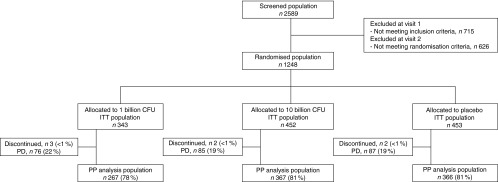
Consort flow chart. CFU, colony-forming units; ITT, intention-to-treat; PD,
protocol deviations; PP, per-protocol.